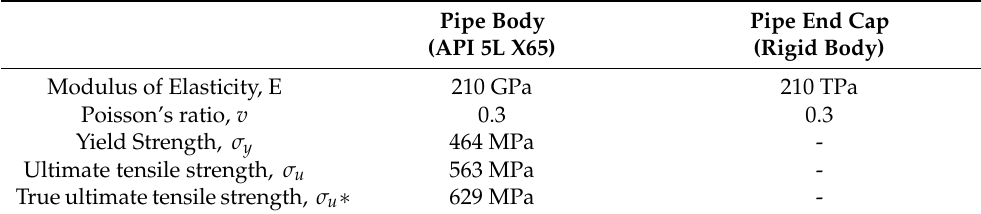
Table 5. Mechanical properties of API 5L X65 steel